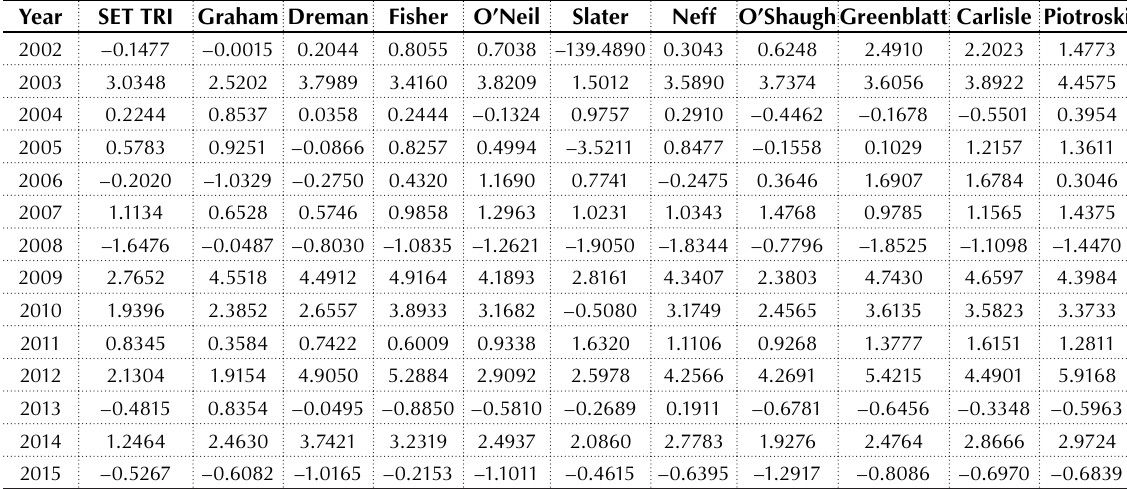
Table 3. The Sharpe ratio of each portfolio and of the Stock Exchange of